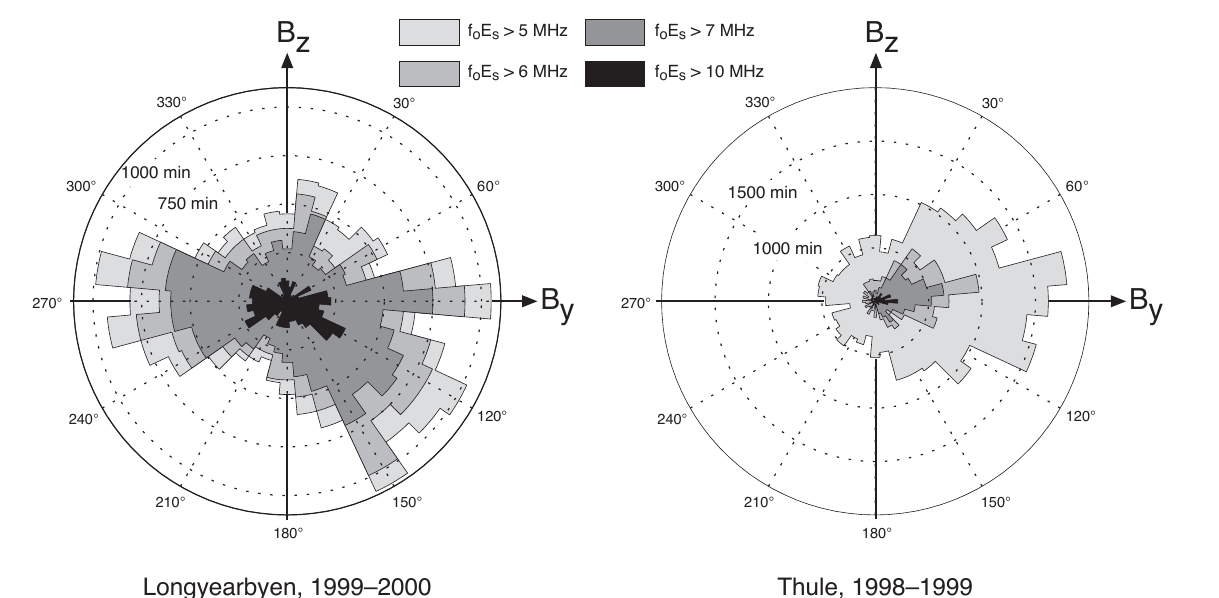
Fig. 4. Distributions of Es occurrence at Longyearbyen and Thule as a function of the clock angle of the IMF in the B y B z plane. Separate distributions are plotted for layers with peak plasma frequencies higher than 5, 6, 7 and